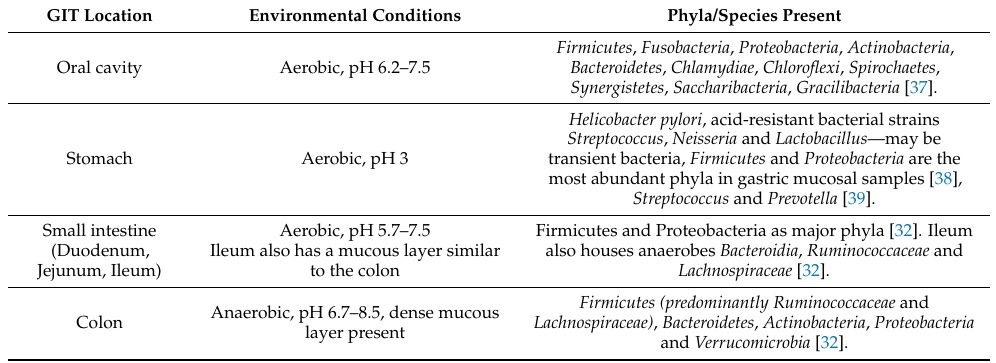
Table 2. Human bacterial microbiota per region of the GIT and local environmental